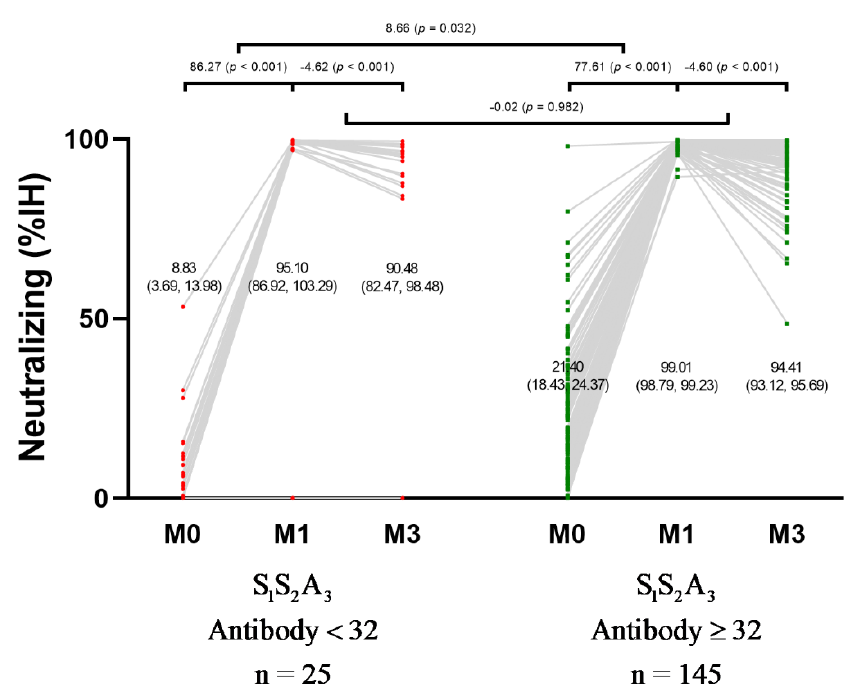
Figure 3. Change in neutralizing antibody level in 170 participants after received ChAdOx1 nCoV-19 as the third dose following two doses of CoronaVac based on the baseline anti-spike IgG status. Neutralizing antibody level reported as percent of inhibition of RBD-ACE2 binding was measured before ChAdOx1 nCoV-19 vaccination (baseline), 1 month post-vaccination, and 3 months post-vaccination. BAU: binding antibody units; IgG: immunoglobulin G; IH: inhibition; S 1 S 2 A 3 : CoronaVac two shots followed by the third dose of ChAdOx1 nCoV-19.